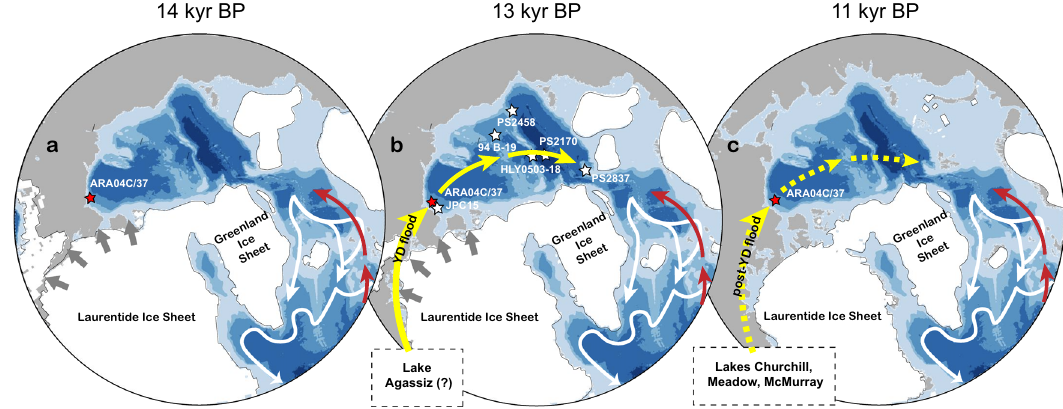
Fig. 3 Schematic illustrations of ice sheets and fl ood events during the deglacial to Holocene transition. a Northern Hemisphere ice-sheet extent at 14 kyr BP . b YD fl ood event at ca. 13 kyr BP . Yellow arrows indicate the possible route of YD fl ood 58 . White stars indicate the studied cores representing the YD fl ood (discussed in text) 19,35,59,71 – 74 . c post-YD fl ood event at ca. 11 kyr BP . Dashed yellow arrows show the possible route of post-YD fl ood from Lake Churchill, Meadow, and McMurray 24 . In ( a – c ), red stars indicate location of Core ARA04C/37, and gray arrows show the melting of the LIS. Red and white arrows represent the warm Atlantic in fl ow to the Nordic Sea and the main bottom currents. Ice-sheet extent (white areas) outlined in ( a – c ) is according to Ref. 96